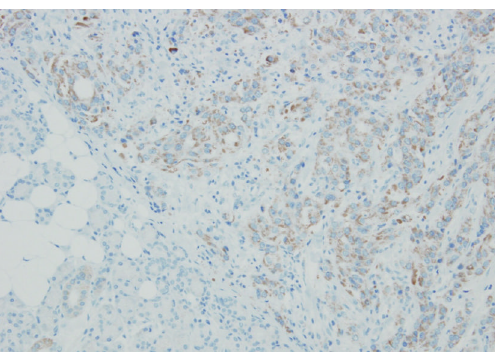
Figure 5: Hematoxylin-eosin staining showing a tumor with exten- sive cytoplasm containing eosinophilic granules in an irregular papillary ring structure. Infiltration of the surrounding salivary gland tissue was also observed. No infiltration of lymph ducts, blood vessels,ornerveperipherieswasevident,andmarginswerenegative.